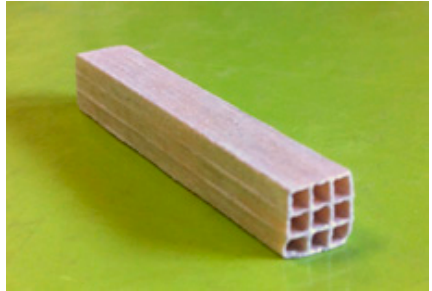
Figure 7. Structured catalyst after calcination at 900 °C for 1 h.